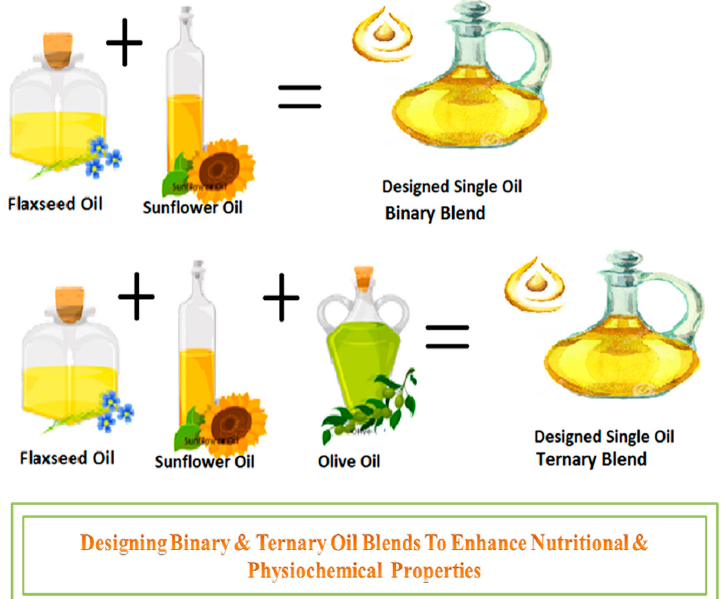
Figure 2. Binary and ternary oil blends.